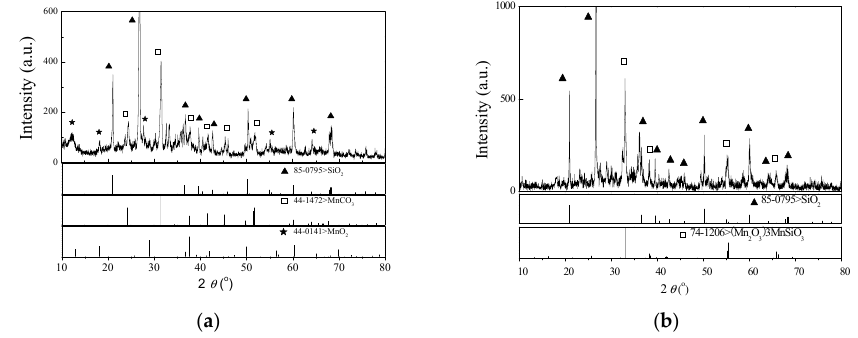
Figure 1. X-ray diffractometer (XRD) pattern of semi-oxidized manganese ore ( a ) and its leaching residue ( b ).